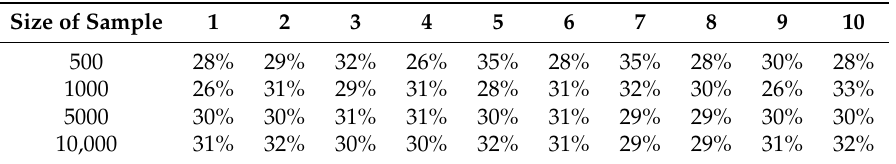
Table 6. Probabilities in ten scenarios (Kernel method). Size of Sample